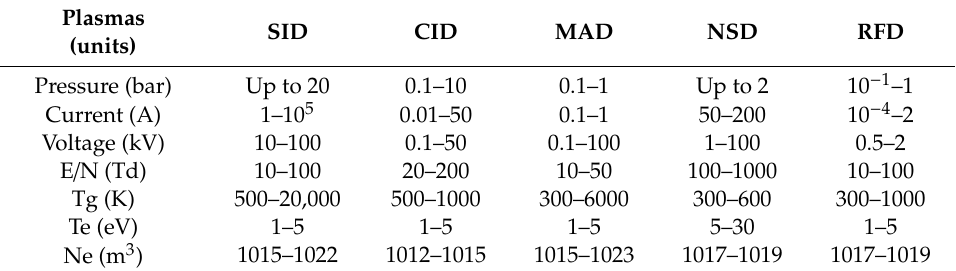
Table 1. Plasma discharge